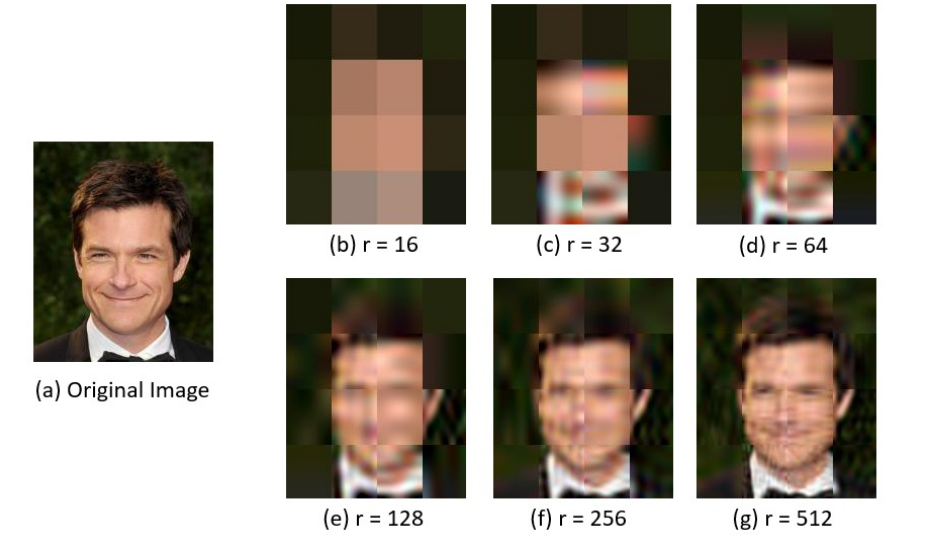
Figure 5. ( a ) Original image ( b – g ) DCC result of a sample image with a = b = 4 and different r values. As r increases, the image becomes clearer and it is easier to distinguish who he